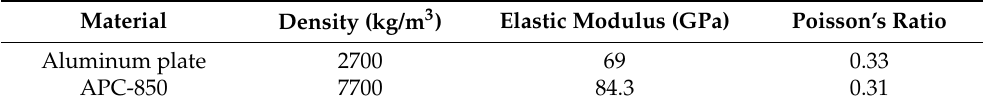
Table 1. Material parameters. Material Density (kg/m 3 ) Elastic Modulus (GPa) Poisson’s Ratio Aluminum plate